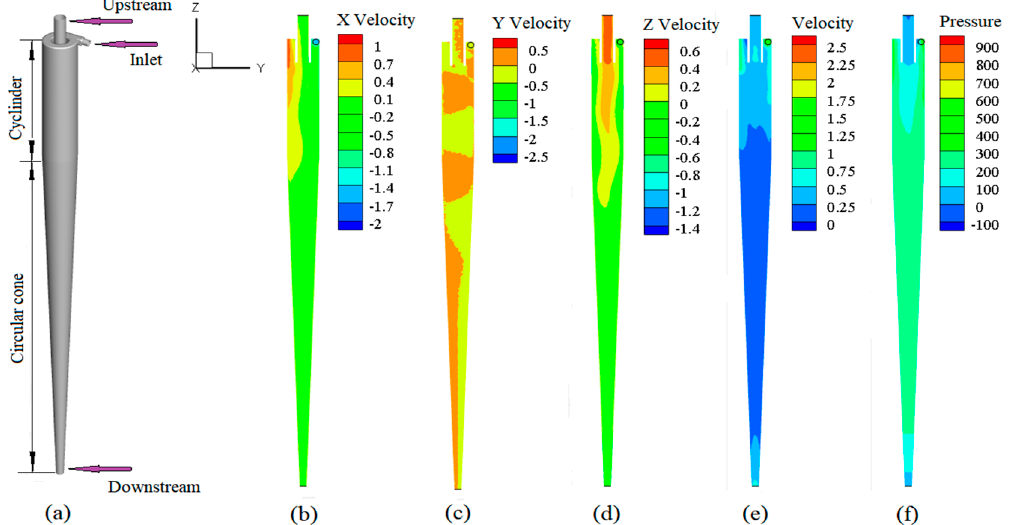
Figure 4. Structure of the cyclone, water flow velocity (m · s − 1 ) and pressure (Pa) distribution: ( a ) structure of hydrocyclone; ( b ) flow velocity in X-axis; ( c ) flow velocity in Y-axis; ( d ) flow velocity in Z-axis; ( e ) water flow velocity distribution; ( f ) water flow pressure distribution.